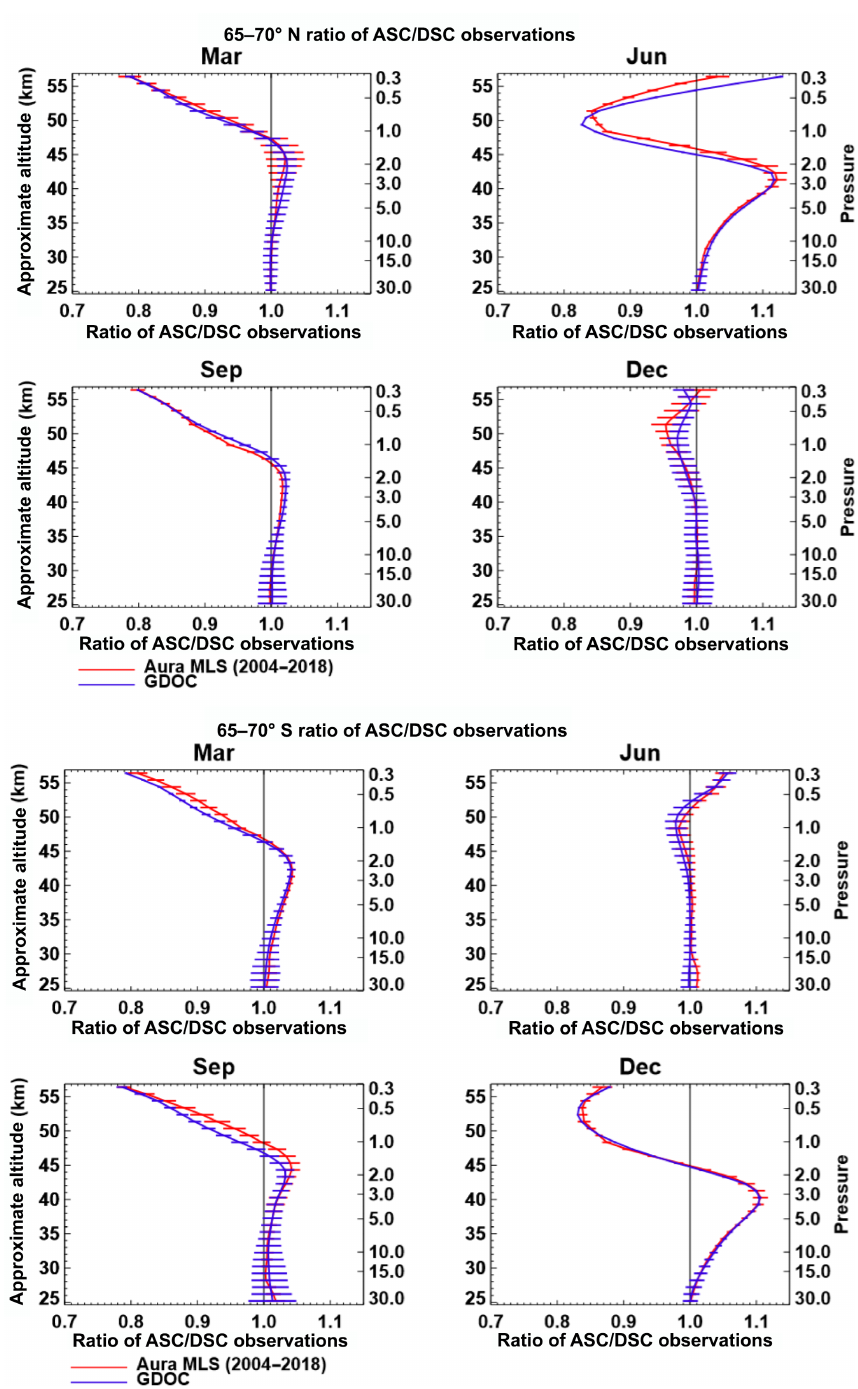
Figure 6. Profile of mean ratio of ascending (day at most latitudes) to descending (night at most latitudes) measurements at 65–70 ◦ N (top four panels) and 65–70 ◦ S (bottom four panels) from Aura MLS (2004–2018) and GDOC subsampled at Aura MLS profile locations/times. The four panels show results for March, June, September and December. Aura MLS error bars indicate the 2-sigma standard deviation of the Aura MLS ascending/descending ratio profiles from year to year. We show the standard deviation to highlight the interannual variability of the ratio observed by Aura MLS. The model error bars are 2SEM, as described in the